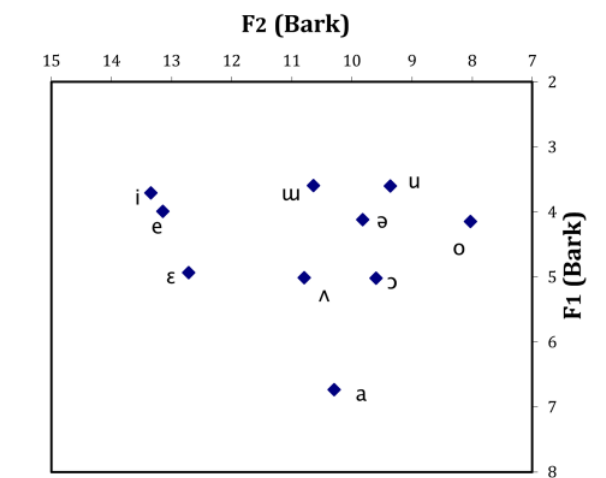
Figure 5. Oral monophthong vowel plots of Aceh Barat Dialect